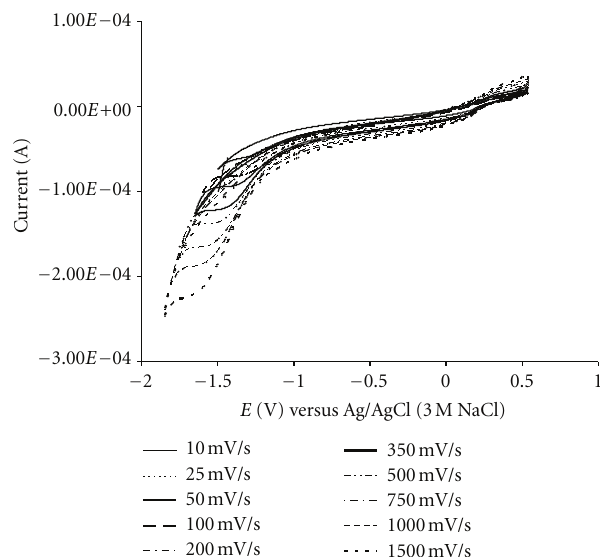
Figure 7: Cyclic voltammograms of 10mM H 2 O 2 at di ff erent sweep rates on 20% (w/w) modified PB SCNRPE. 0.1M phosphate bu ff er, pH = 7.0.